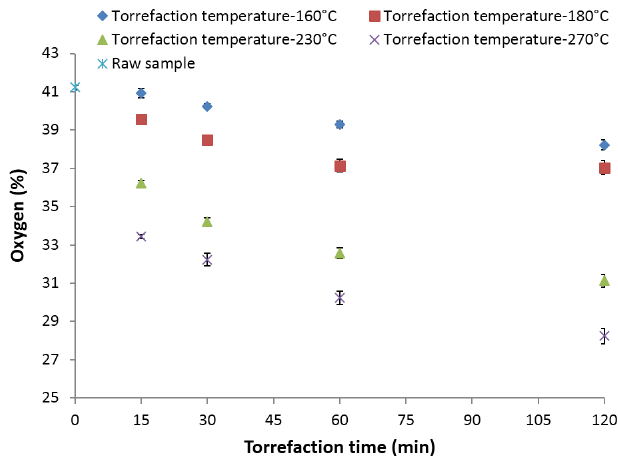
Figure 10. Oxygen content in the lodgepole pine biomass with respect to the torrefaction time and